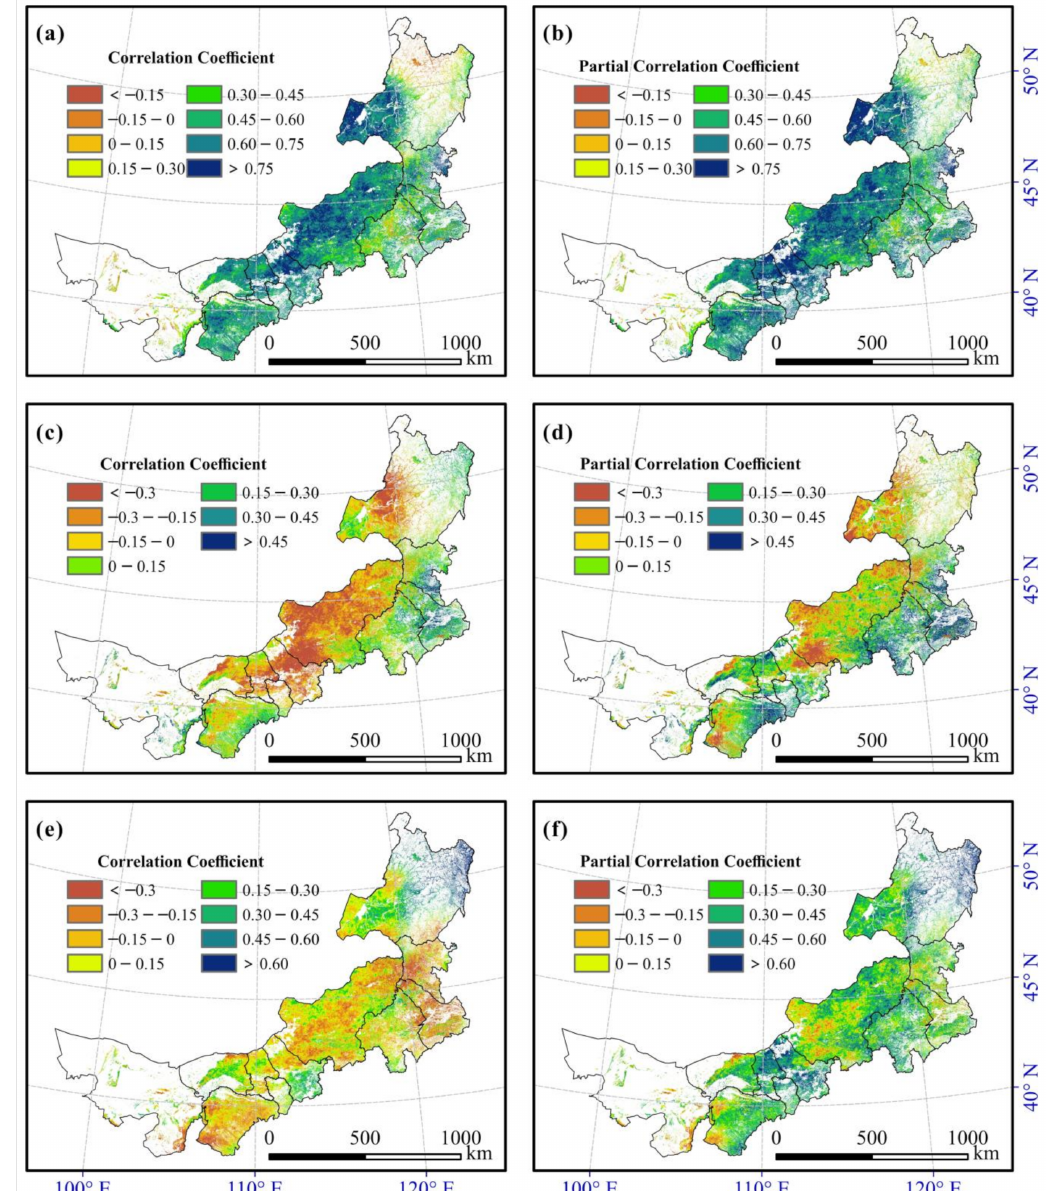
Figure 12. Spatial distribution of the correlation coefficients and partial correlation coefficients between grassland NPP and precipitation ( a , b ), temperature ( c , d ), and sunshine duration ( e , f ) in Inner Mongolia during 2000–2020. For temperature, the correlation between NPP and temperature is not consistent in spatial distribution, as shown in Figure 12c,d. About 61.80% of the total grassland